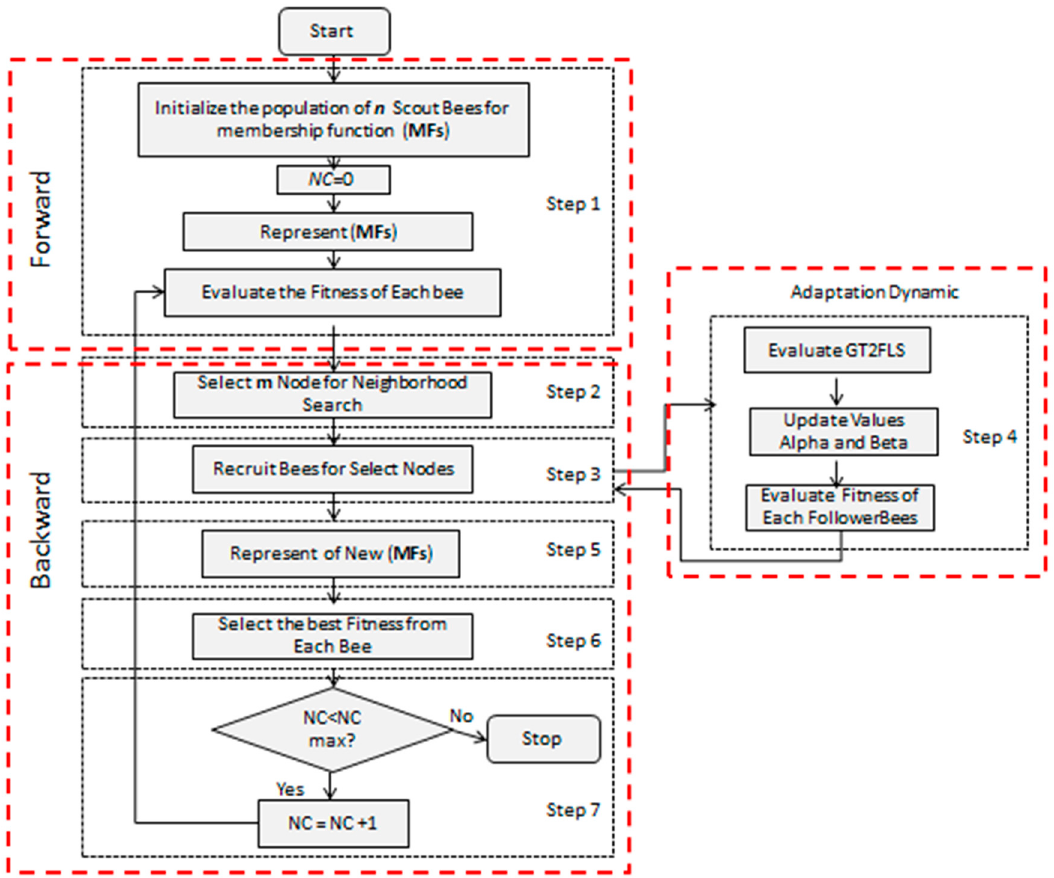
Figure 14. Flowchart of the proposed Fuzzy BCO.